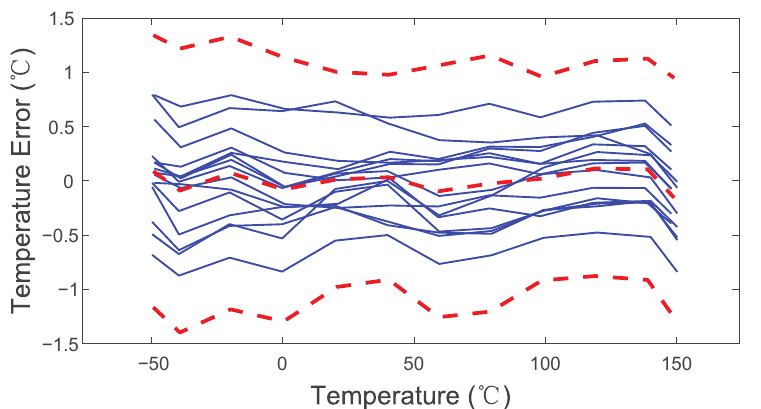
Figure 14. Untrimmed temperature error of 15 sensors; red dashed lines refer to the average and 3 σ